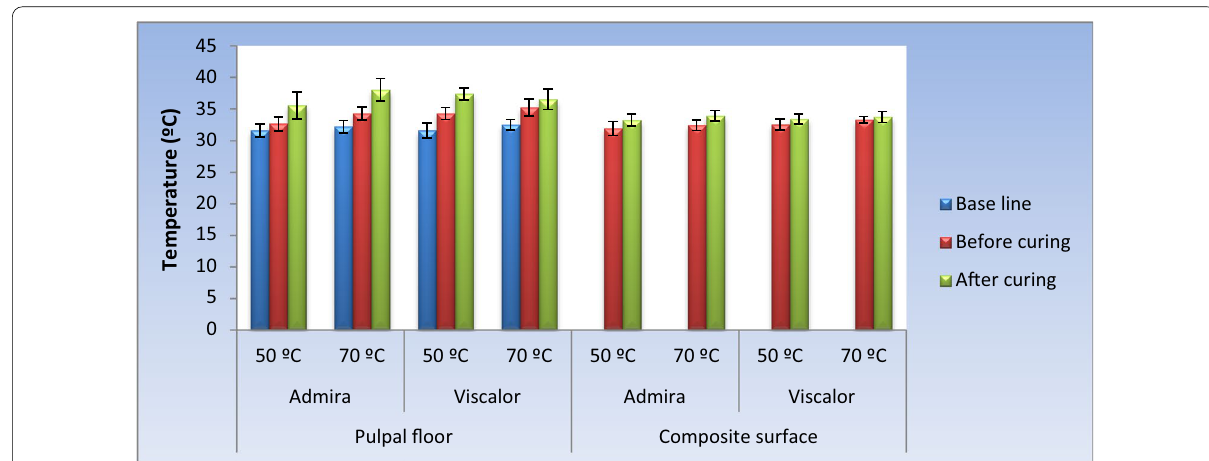
Fig. 3 Temperature measurements (°C) before and after curing are represented as a bar chart with mean and standard deviation